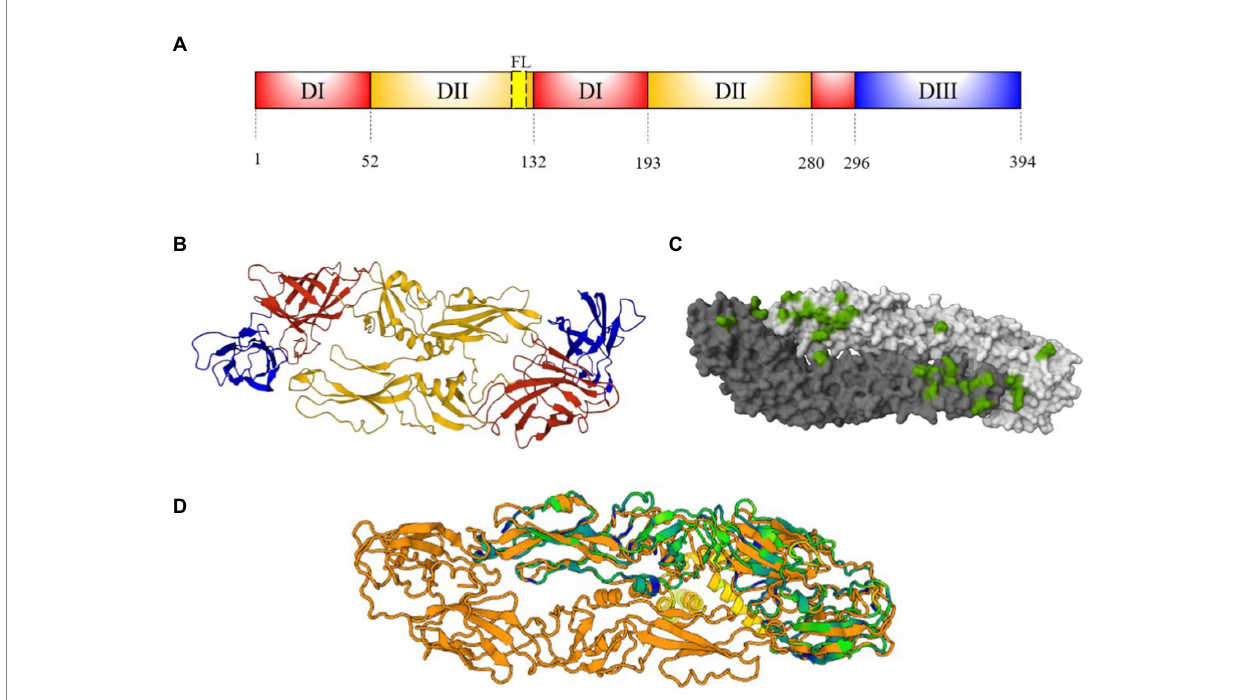
FIGURE 4 E protein structure. (A) Schematic representation of E-protein ectodomain showing EDI (red), EDII (orange), FL (yellow) and EDIII (blue). Numbers below represent the residue positions. (B) Ribbon structure of DENV E antiparallel dimer (PDB: 1UZG) (Modis et al., 2005). Domains on dimer are represented as (A,C) Footprint of EDE2 Fab C8 mAb on a DENV-2 antiparallel dimer (4UTC) representation shown in green (Barba-Spaeth et al., 2016). (D) DENV (1UZG) and ZIKV (5IRE) E dimer superposition [Dali server: (Holm, 2022)]. ZIKV-NS1 sequence A (green) (Sirohi et al., 2016) is super posited on DENV-3-E sequence A and B (orange). Cyan and blue regions indicate conserved motifs and conserved amino acid sequences, yellow motifs indicate DENV-E intracellular